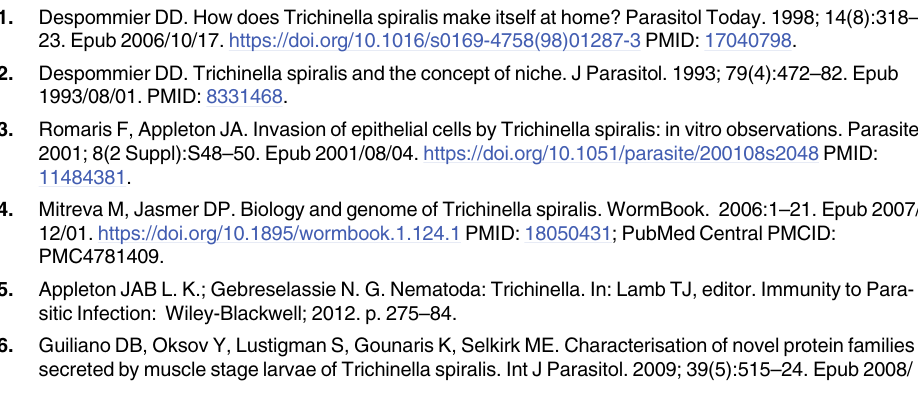
S1 Table. Candidates isolated from T . spiralis mL1 EST datasets. This table shows the top 11 candidates identified in the informatics screen of the T . spiralis mL1 EST dataset with their names and Genbank accession numbers. The columns next to the identifier show the number of ESTs for each transcript that were identified in the T . spiralis mL1 and adult EST datasets. Homologies to sequences contained within Genbank, the NEMBASE4 cluster (accessed 08/11/ 19) and number of ESTs derived from these clusters are shown [41]. No NBL ESTs were mem- bers of the clusters derived from these